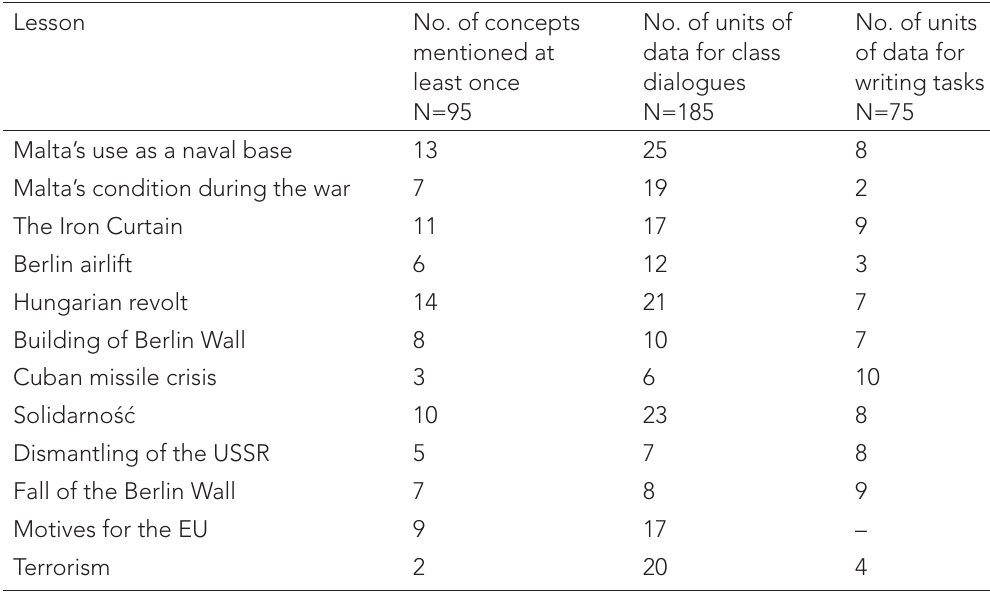
Table 2: Number of concepts in each lesson and their frequency in units of data Lesson No. of concepts mentioned at least